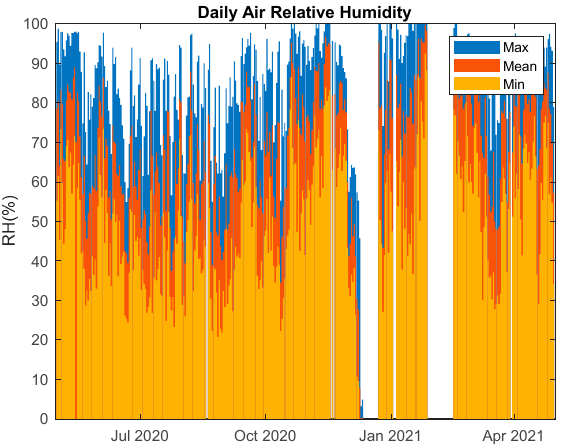
Figure 5. Maximum, mean, and minimum annual air relative humidity.